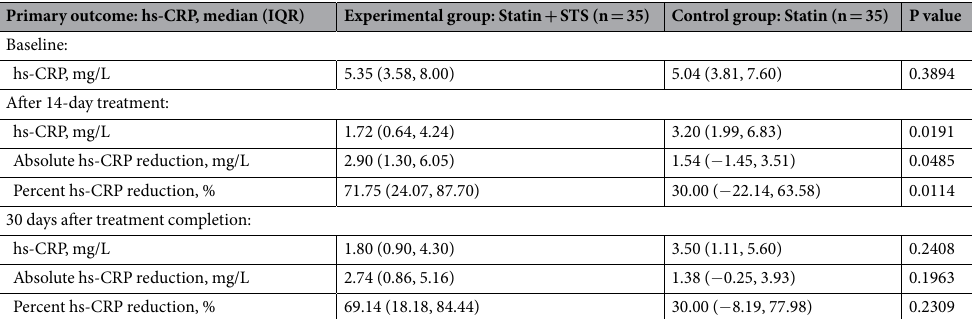
Table 2. Comparison of hs-CRP between groups at baseline and after treatment. hs-CRP, high-sensitivity C-reactive protein; IQR, interquartile range; STS, sodium tanshinone IIA sulfate. Inter-group comparison was analyzed using the Wilcoxon rank-sum test, due to non-normal distribution of the